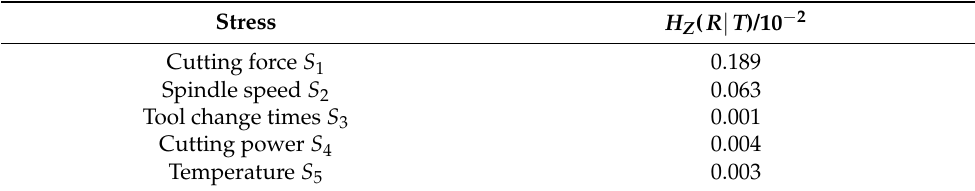
Table 9. Comprehensive importance of